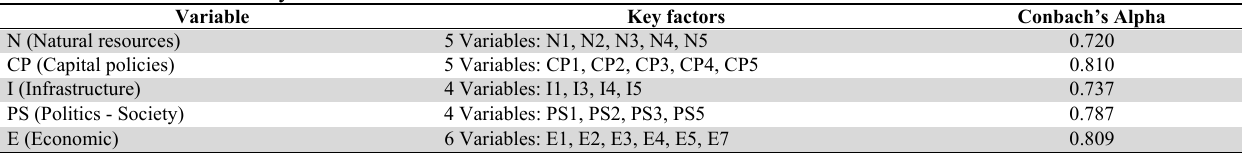
Results of the scale reliability